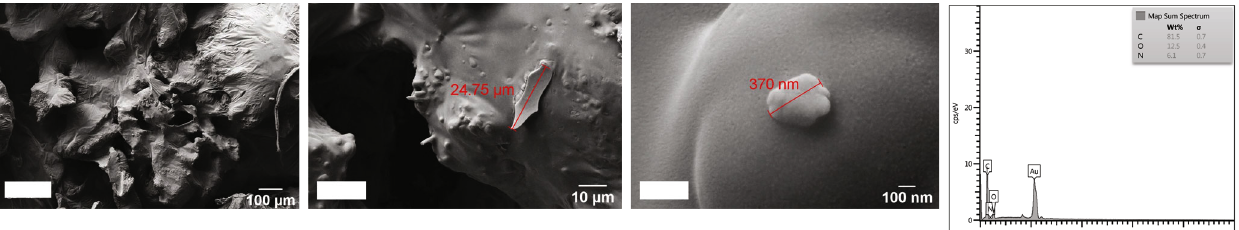
Figure 16: SEM images and energy-dispersive spectroscopy (EDS) analysis of PURFs PU-S4-1.